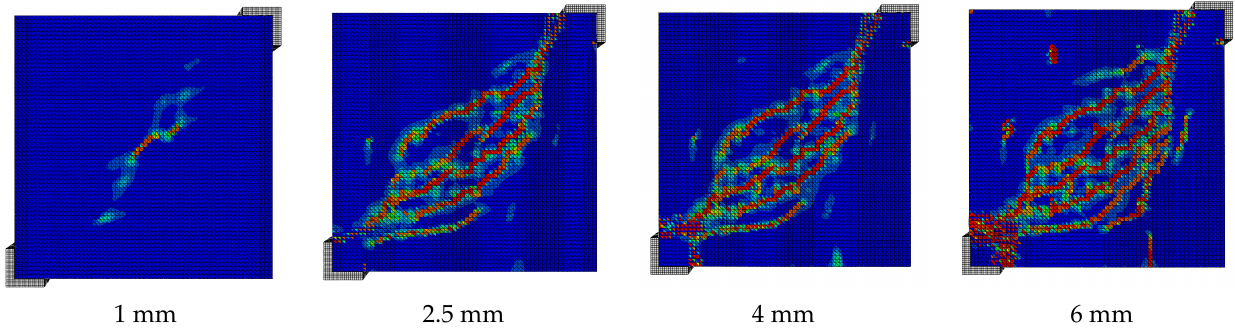
Figure 9. Damage evolution of tension.